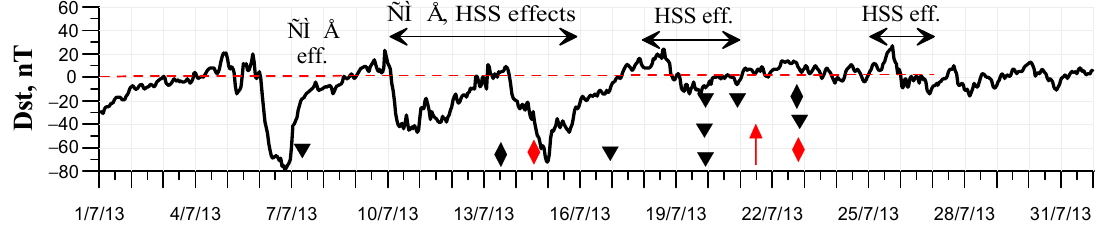
Figure 8. Variations of the Dst index and the thunderstorm activity in July 2013.